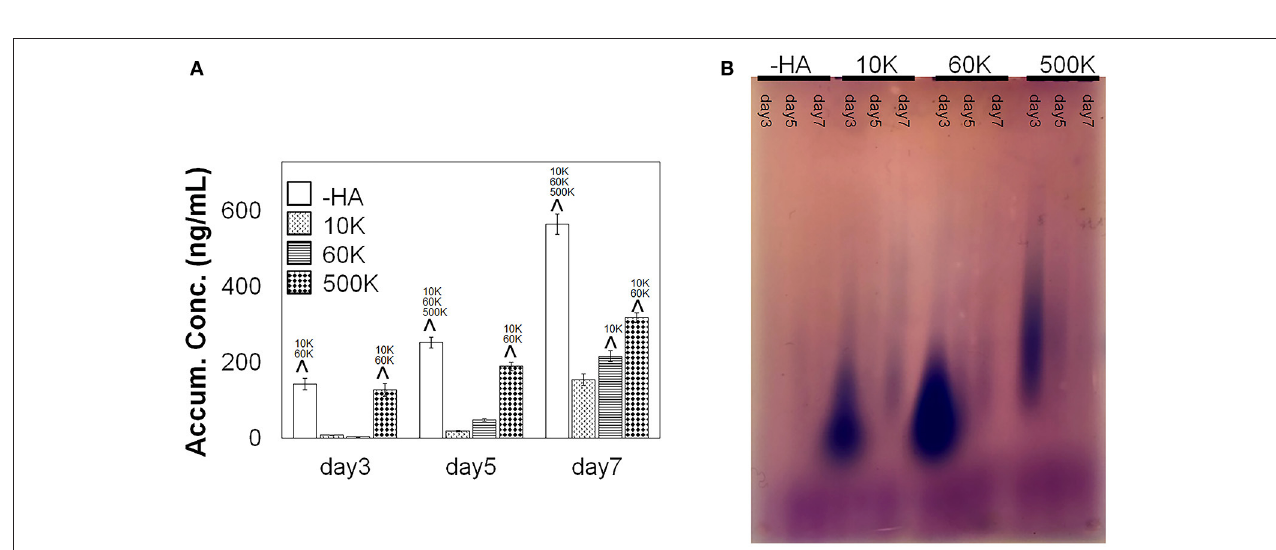
FIGURE 4 | (A) Accumulative of soluble HA in the media over the course of GBM culture in GelMA hydrogels, measured via ELISA ( n hydrogels lacking any matrix immobilized HA (-HA) showed secreted significantly higher amount of soluble HA compare to GBM cells cultured within GelMA hydrogels containing matrix-bound HA. Production of soluble HA by GBM cells in GelMA hydrogels containing matrix-immobilized HA were strongly sensitive to the molecular weight of the matrix immobilized HA. Notably, soluble HA secretion increased with the MW of immobilized HA, with the 500 K group secreting significantly higher amount of soluble HA compare to 60 and 10 K. ∧ p < 0.05 significant increase between different groups. (B) Agarose gel showing the molecular weight distribution of HA in culture media (blue). Low molecular weight chondroitin sulfate appears in purple. The most intense signals are samples at day 3 for 10, 60, and 500 K